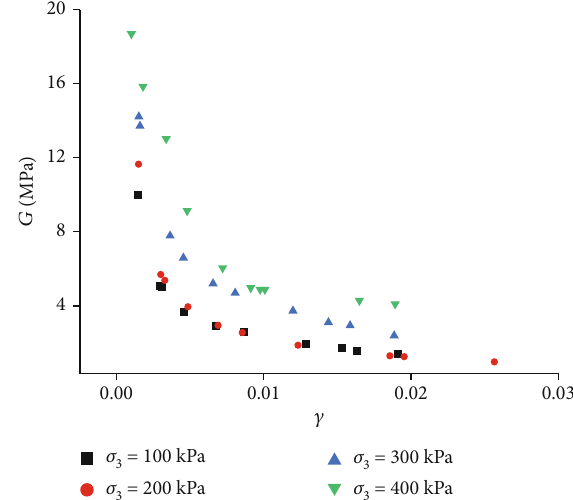
Figure 4: Relationship between shear modulus and shear strain.